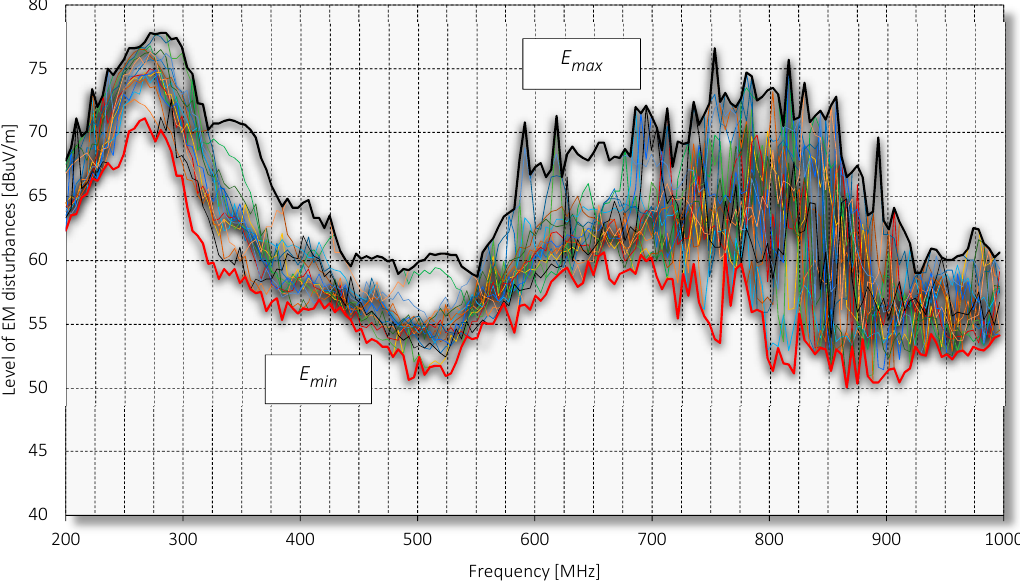
Figure 7. Levels of electromagnetic disturbances (valuable emissions, 15 measured devices of the same type) measured for laptops C in the range of frequencies from 200 MHz to 1 GHz, BW = 50 MHz, measurement distance: 1 m.